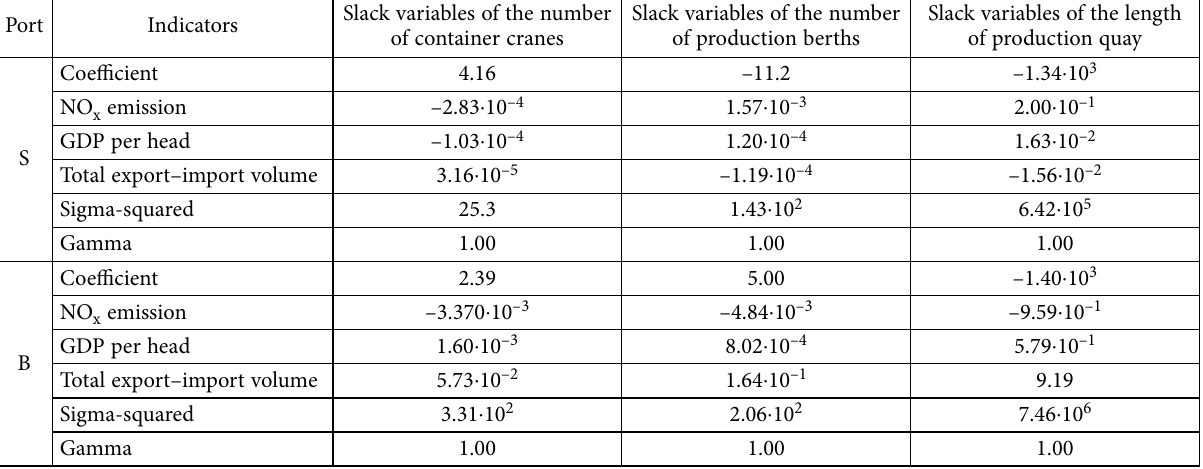
Table 3. Results of the second